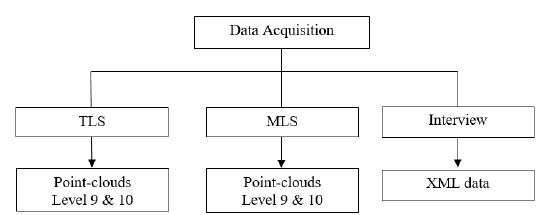
Figure 2. Data acquisition techniques